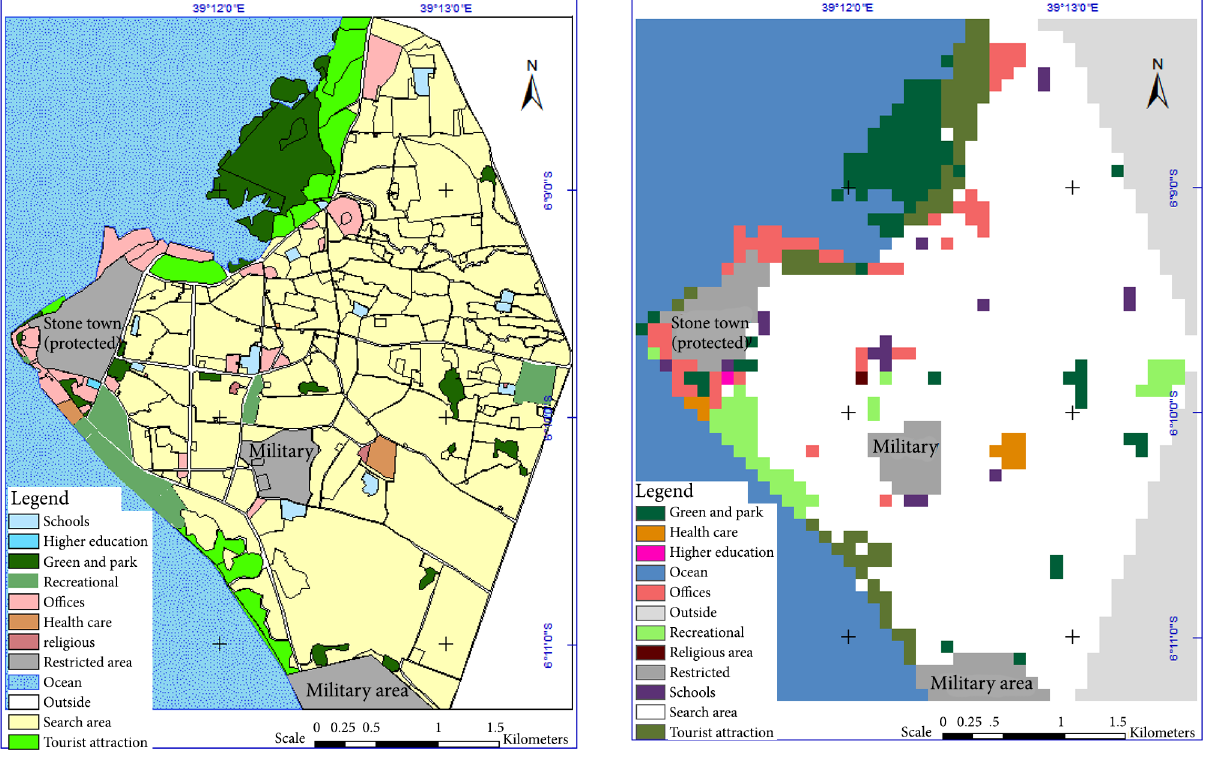
Figure 3. Map showing the existing land-uses of Zanzibar, with a classification where important features are emphasized